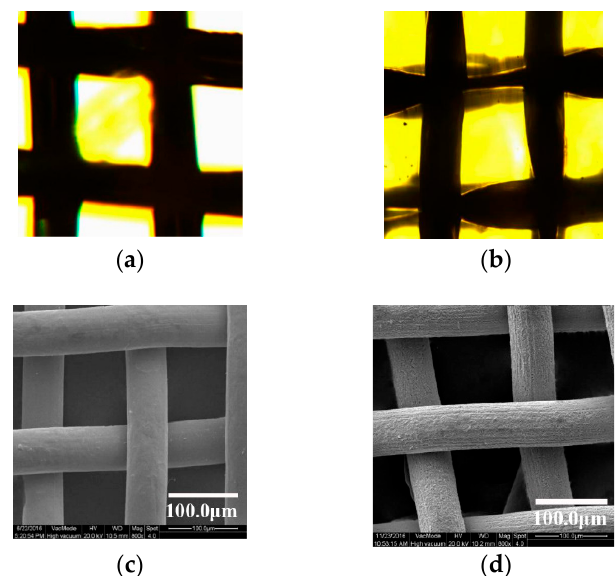
Figure 2. Copper mesh morphologies under microscope and SEM: ( a , c ) untreated; ( b , d ) etched and oxidized.